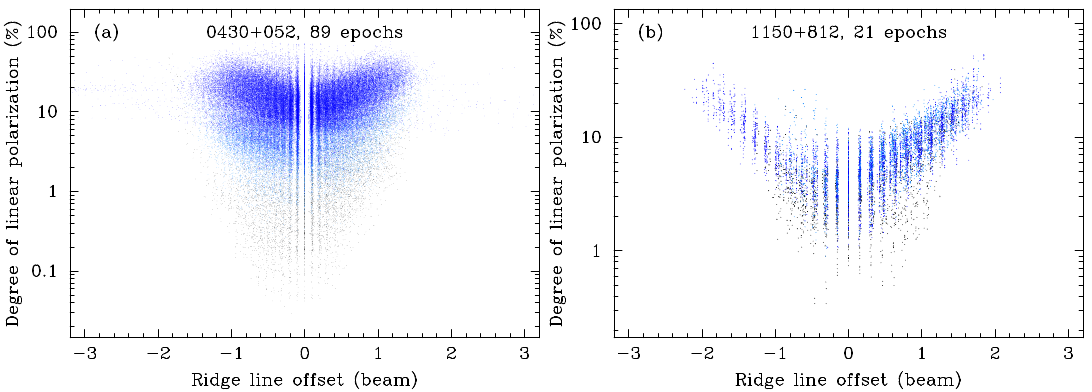
Figure 4. ( a ) Fractional polarization from slices transverse to the local jet direction as a function of offset from total intensity ridgeline for the radio galaxy 3C 120 (0430+052). Black, cyan and blue dots show measurements at distances r < 1 mas, 1 < r < 3 mas, and r > 3 mas from the 15 GHz core measured along ridgeline, respectively. ( b ) Same for the quasar